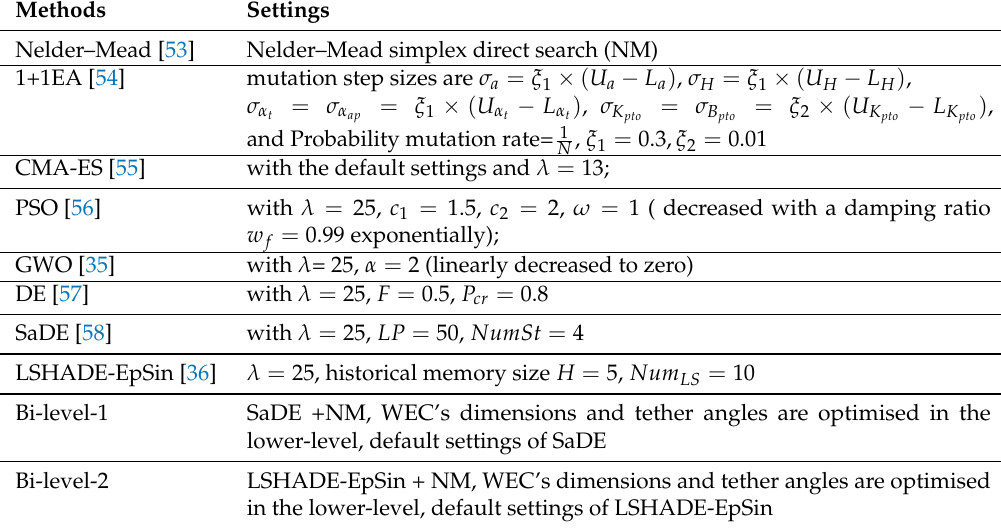
Table 3. The details of the optimisation methods settings. All approaches are restricted to the same evaluation